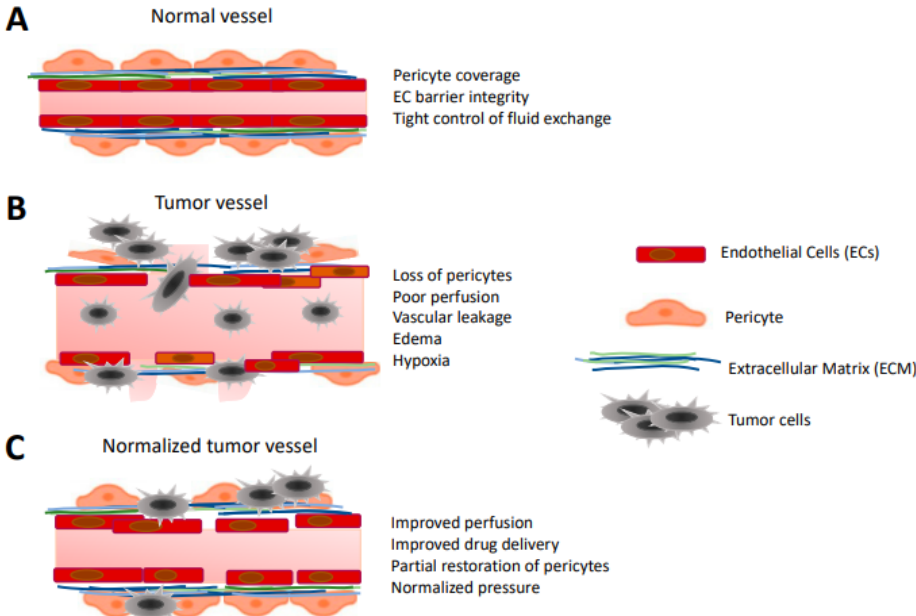
Figure 3. Versatile vessel structures in the course of GBM progression. ( A ) Normal, healthy vessel presents well-organized endothelial cell (EC) layers that are connected with robust junctions and ensheathed with pericytes. ( B ) Abnormal tumor vessel exhibits loss of endothelial junctions leading to increased leakiness and edema. Some of the ECs are transformed, presenting mesenchymal-like phenotype. The pericyte layer is abrogated and the blood brain barrier (BBB) is dysfunctional, hypoxic areas are present. ( C ) Normalized tumor vessel displays better perfusion, partially restored EC and pericyte coverage with semi-functional BBB. Normalized vessels improve drug delivery, while leakiness is